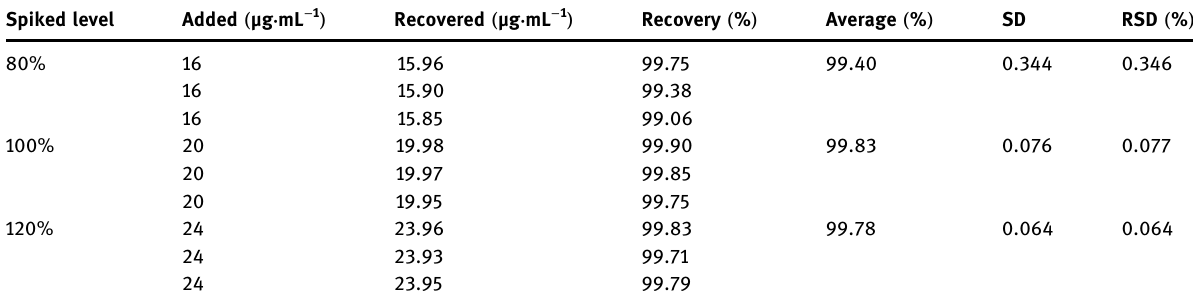
Table 4: The results of the accuracy study Spiked level